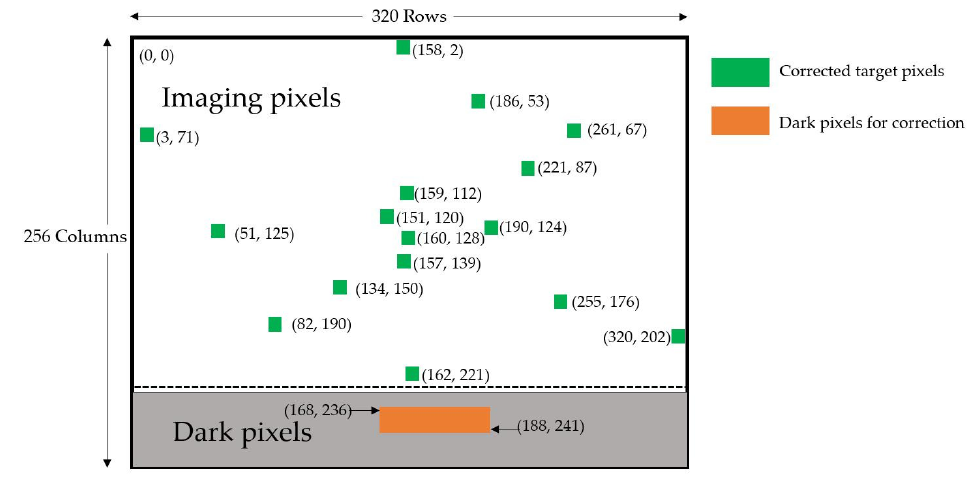
Figure 8. Position of the selected pixels.